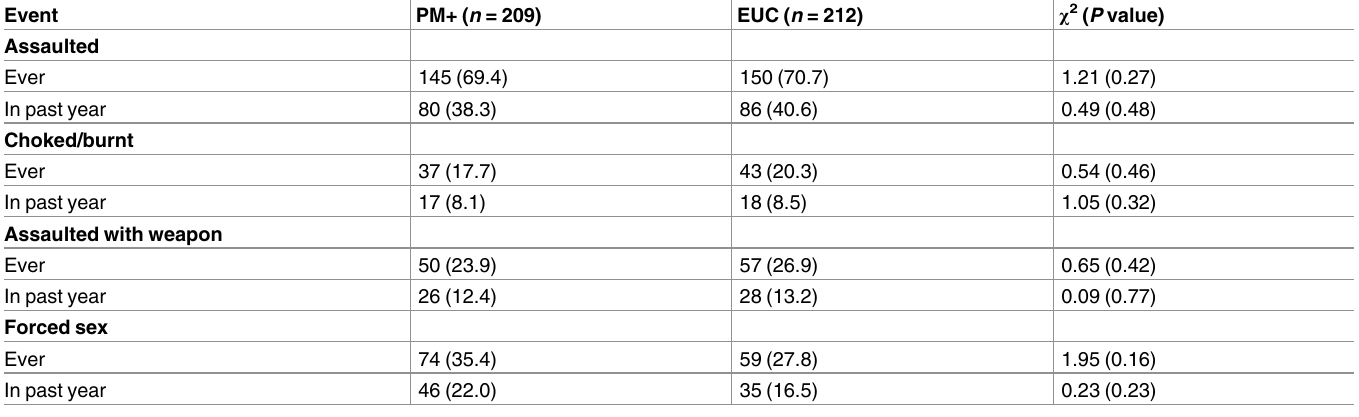
Table 2. Violence against women assessedat